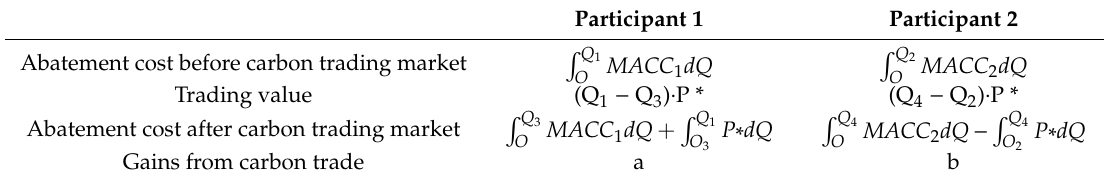
Table 5. Welfare analysis of carbon trading